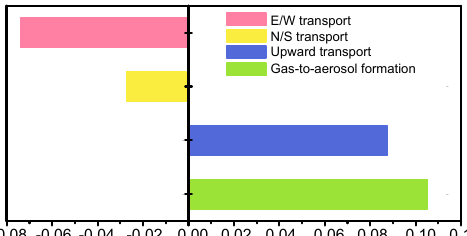
Figure 14. Mass budget for nitrate aerosol within the selected box of 70–105 ◦ E, 10–40 ◦ N, 8–16km. E/W transport indicates net mass flux through the east and west lateral boundaries, N/S transport in- dicates net mass flux through the north and south lateral boundaries, and upward transport is the net mass flux through the top and bot- tom sides of the box. The mass flux is positive if it increases nitrate mass within the box. Unit of fluxes is Tgseason − 1 . All the values are the averages over June–August of